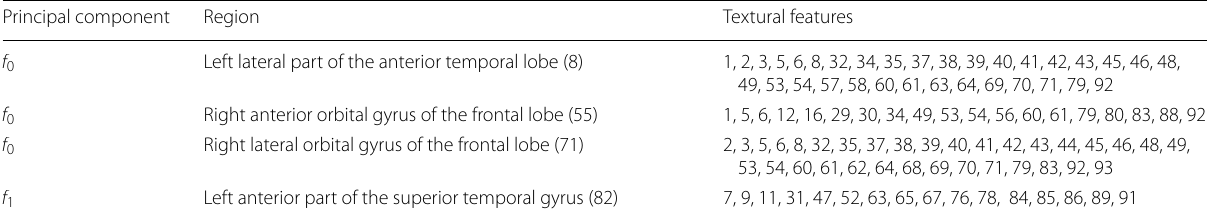
Table 4 Selected principal components and most significant textural